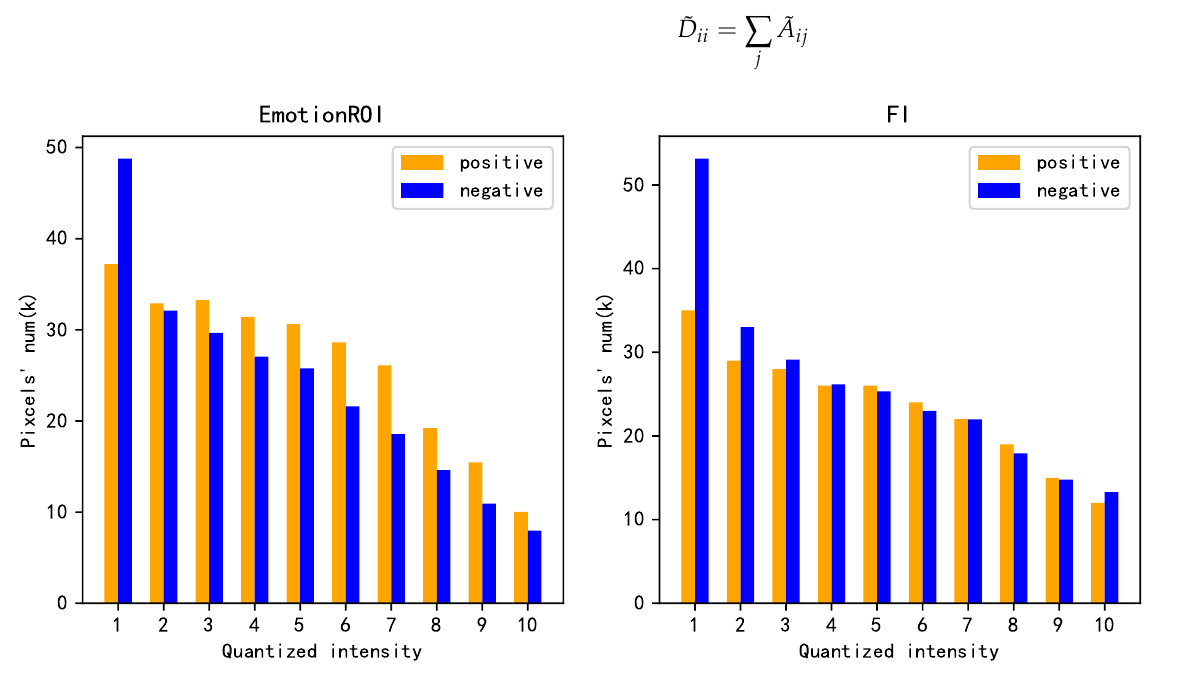
Figure 4. Distribution bar chart displaying the number of brightness pixels of different emotion categories in the EmotionROI and FI